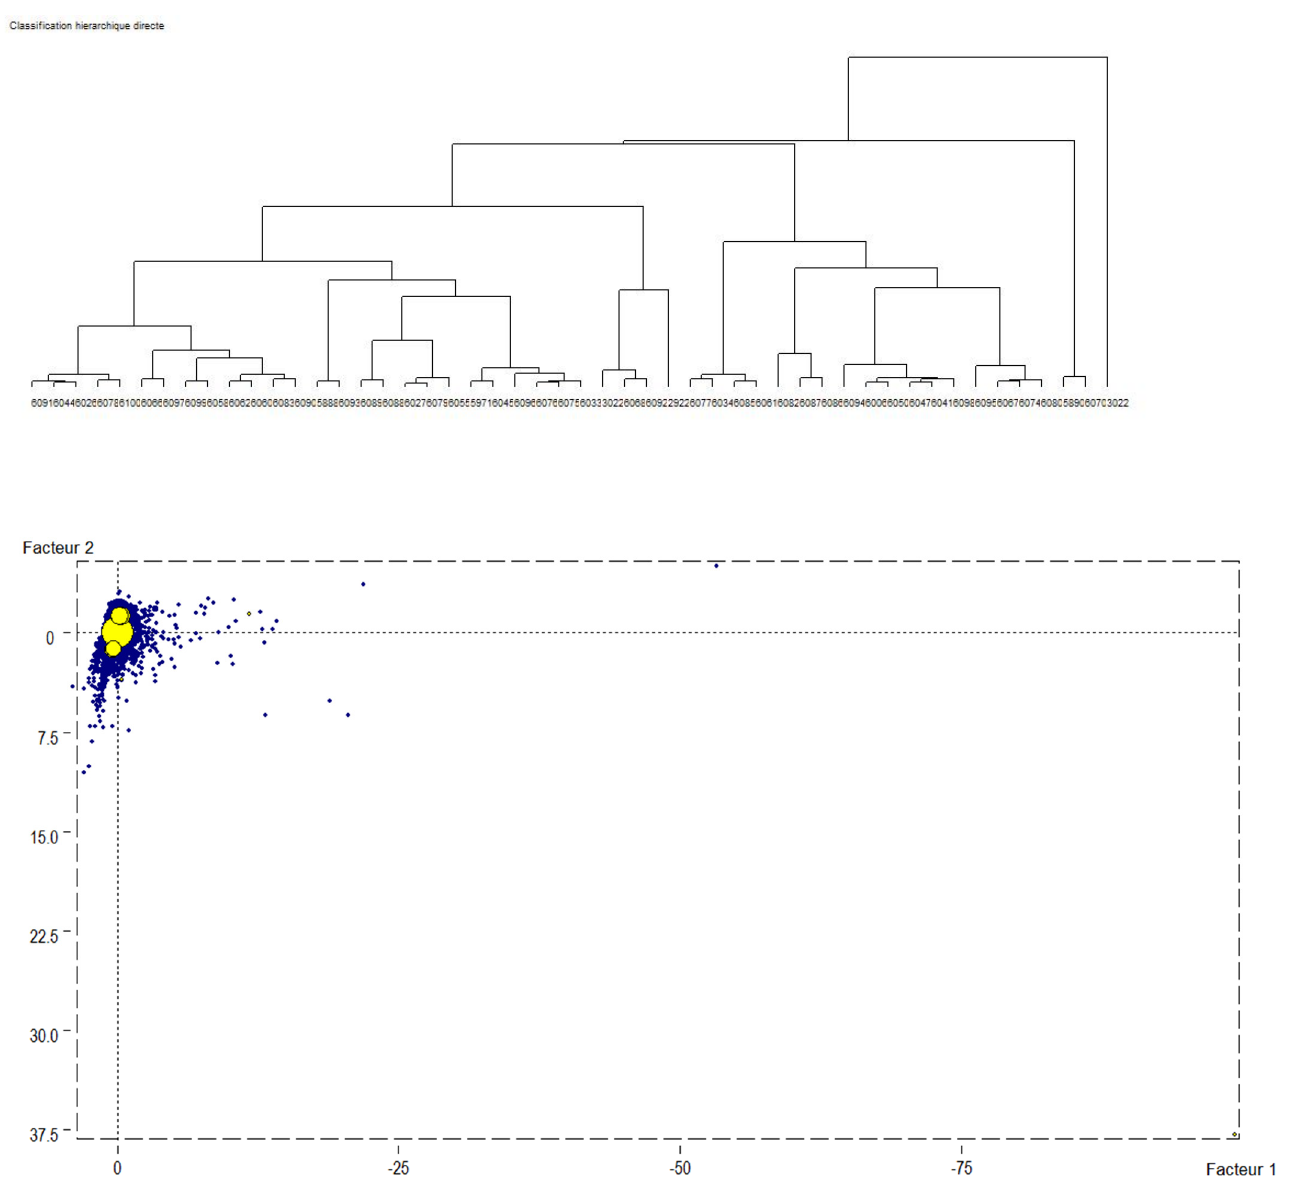
Figure A4. Cluster analysis dendrogram and graph for the southern geographic distribution.